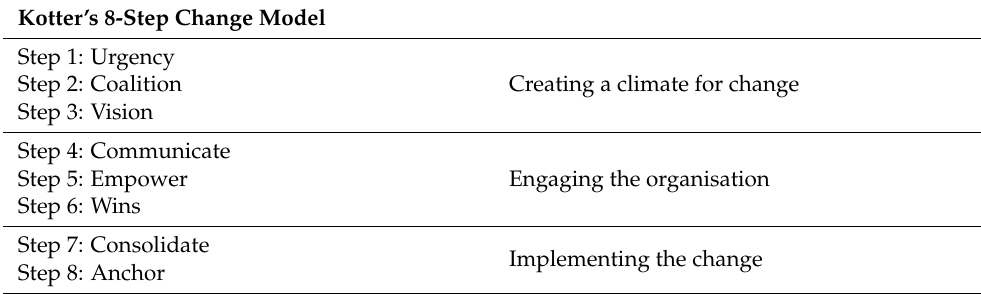
Table 1. John Kotter’s eight-step change